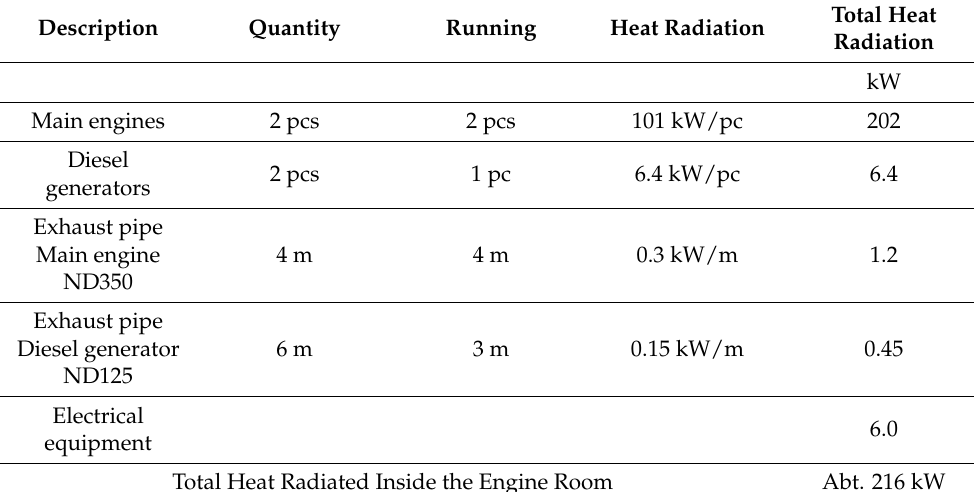
Table 1. Heat radiating inside the engine room [6–9].